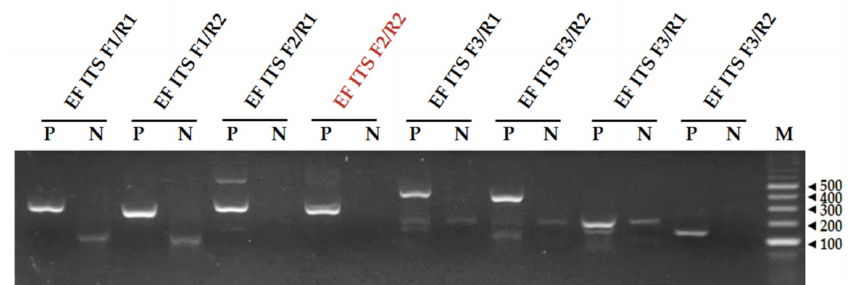
Figure 2. Screening of primer pairs with an RPA assay. The names of the primer pairs are indicated on the top. The sizes of the DNA ladder bands are shown on the right (bp). EF ITS: Elsinoë fawcettii internal transcribed spacers, F: forward primer, R: reverse primer, P: presence of template, N: no template, negative control, M: size marker. The reactions were performed at 37 ◦ C for 20